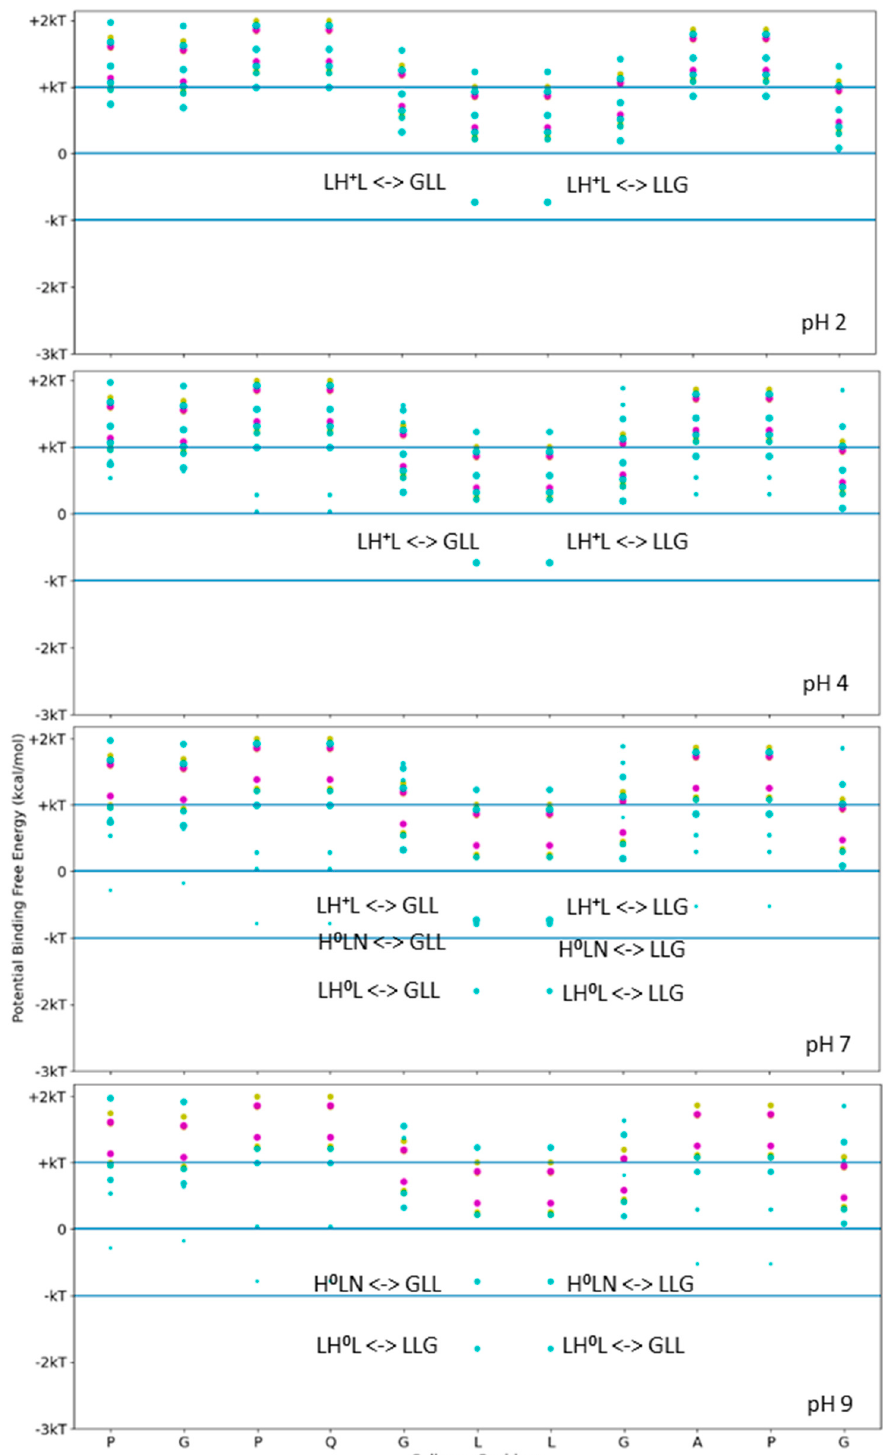
Figure 3. Free energy of binding estimates for sets of three adjacent residues for different collagen- binding peptides on human collagen type I alpha chain 2 (COL1A2) residues 861–871. Positive bind-